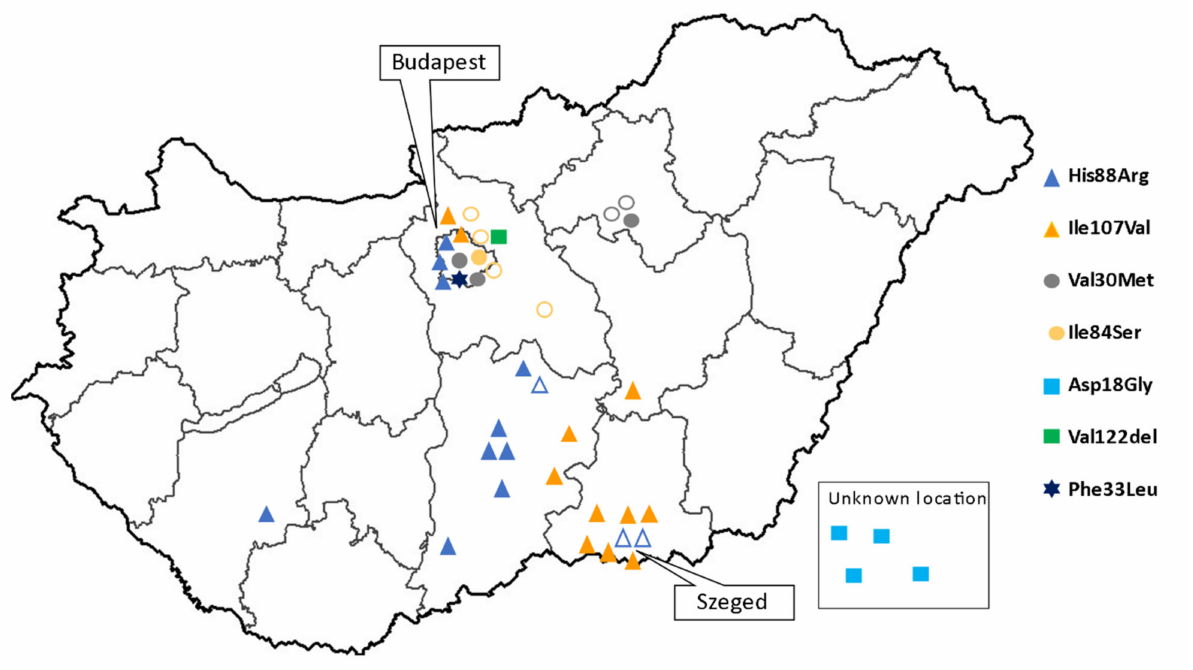
Figure 2. A map of Hungary with geographic distribution of different genetic subtypes of ATTRv patients ( n = 40). Full symbols represent symptomatic individuals, while empty symbols represent asymptomatic individuals. The four patients with unknown locations are the patients found during literature